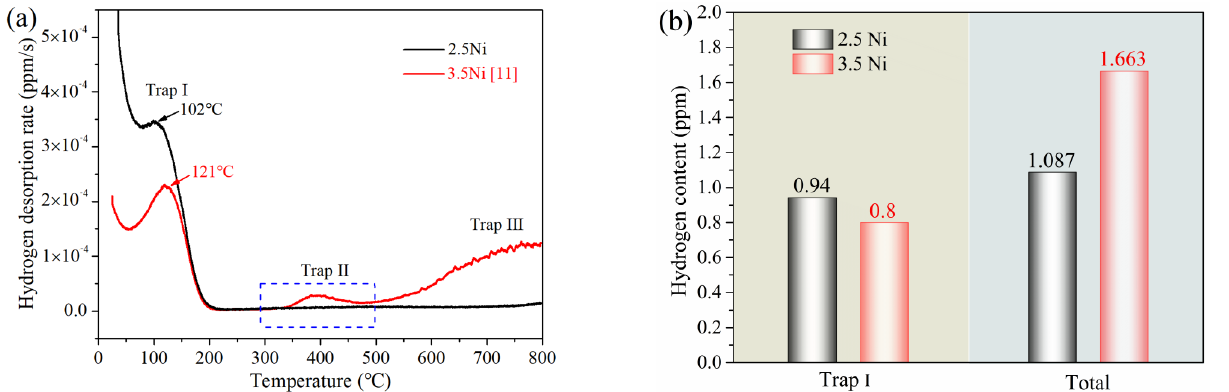
Figure 18. ( a ) Hydrogen desorption rate curves (TDS curves). ( b ) Hydrogen content of hydrogen- charged specimens. charged